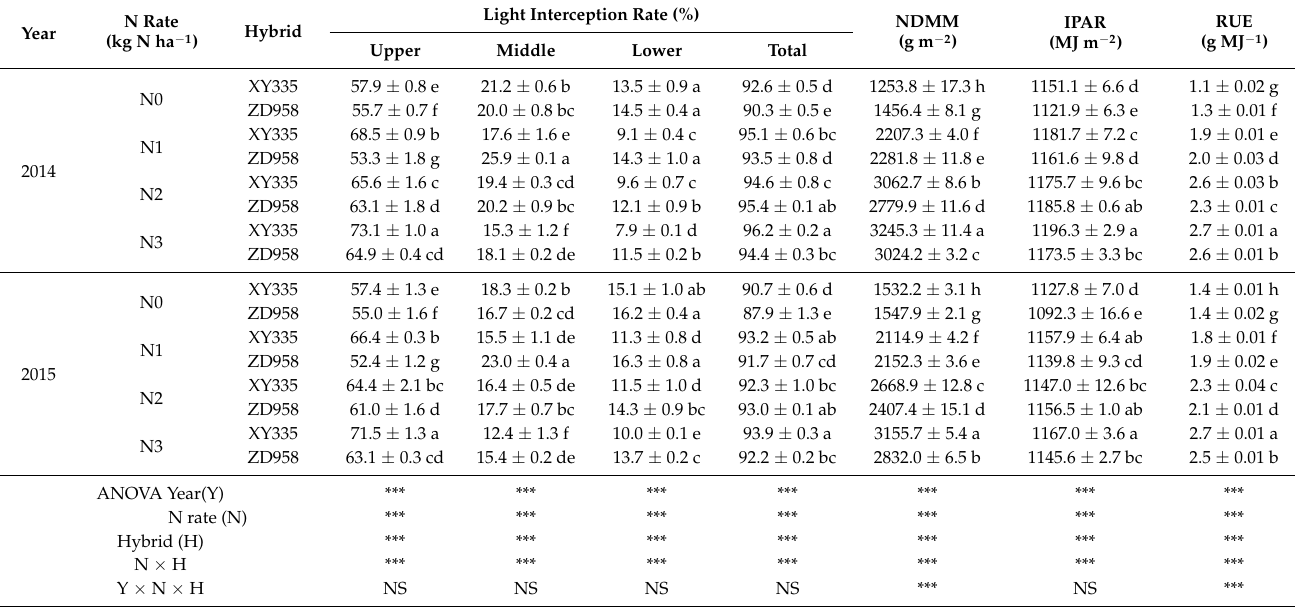
Table 3. Light interception rate, NDMM, and RUE of maize of different genotypes at a high plant density in 2014 and